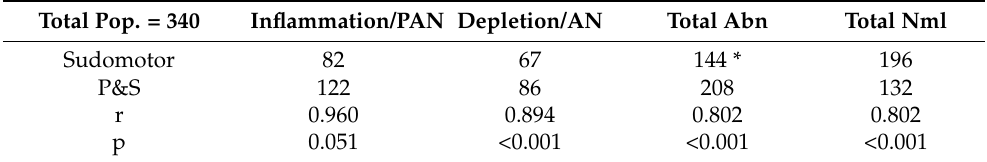
Table 1. Sudomotor and P&S responses.